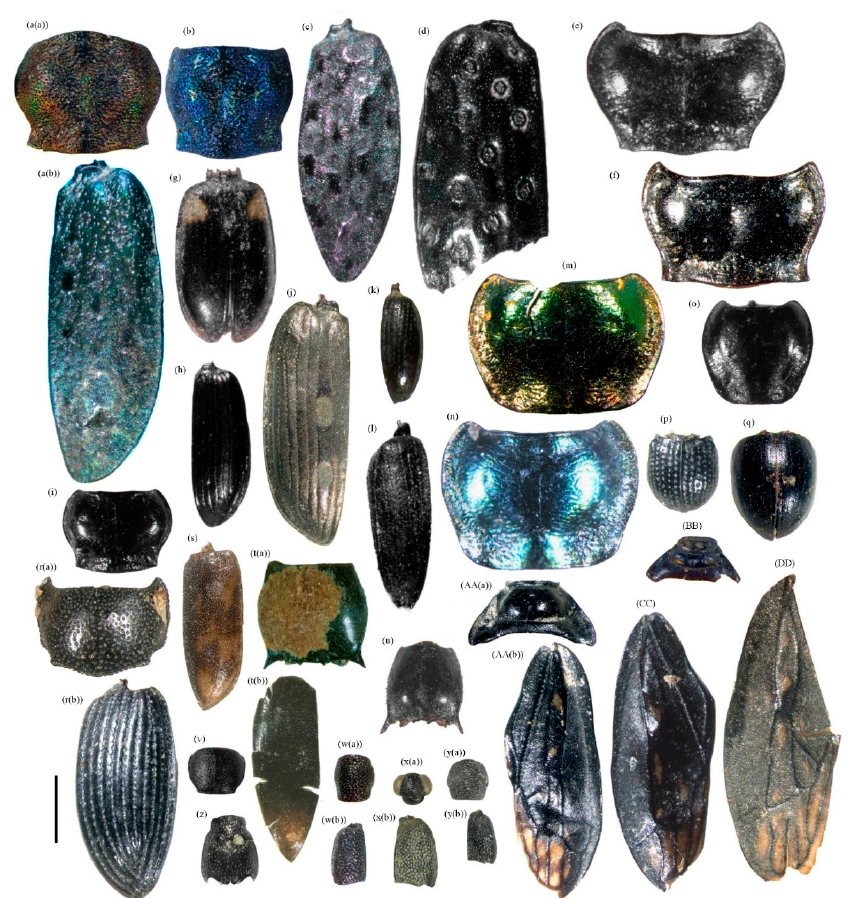
Figure 13. Remains of insects from plant litter, muddy and sandy water edges: (a)— Elaphrus lappon- icus , (b)— E. parviceps , (c)— E. angusticollis , (d)— E. clairvillei , (e)— Nebria frigida , (f)— N. rufescens , (g)— Bembidion mutatum , (h)— B. arcticum , (i)— B. umiatense , (j)— B. lapponicum , (k)— Dyschiriodes melan- cholicus , (l)— Dyschirius polius , (m)— Agonum sexpunctatum , (n)— A. cupreum , (o)— A. consimile , (p)— Georyssus crenulatus , (q)— Cercyon borealis , (r)— Aegalia kamtschatica , (s)— Heterocerus fenestratus , (t)— Negastrius restrictulus , (u)— Hypnoidus bicolor , (v)— Bledius viriosus , (w)— Stenus fuscipes , (x)—S. au- reoles, (y)— S. palustris , (z)— Stenus sp., (AA)— Salda littoralis , (BB)—Saldula fucicola , (CC)— Teloleuca pellucens , (DD)— Chiloxanthus stellatus . ((a), BB) Ulakhan-Sullar: (a(a)) middle Pleistocene, (BB) late Pleistocene; (b, d, h, l) Lucky Lady, (g) Hollis Mine, (e, l, n, o, t, u, v) Quartz Creek: (a(b), b, d, e, n, o, u, v)—Holocene, (g): middle Pleistocene, (c, h, i, l, u)—late Pleistocene), (f, CC) Ust-Buotama, (j, k, p, r, t(a), w, DD)—Kharyyalakh, Holocene, (m)—Kyzyl-Syr, late Pleistocene (MIS3) peat, (q) Un- dulung River, late Pleistocene, (x, y, z)—Batagay, late Pleistocene, (AA) Kyzyl-Syr, late Pleistocene .